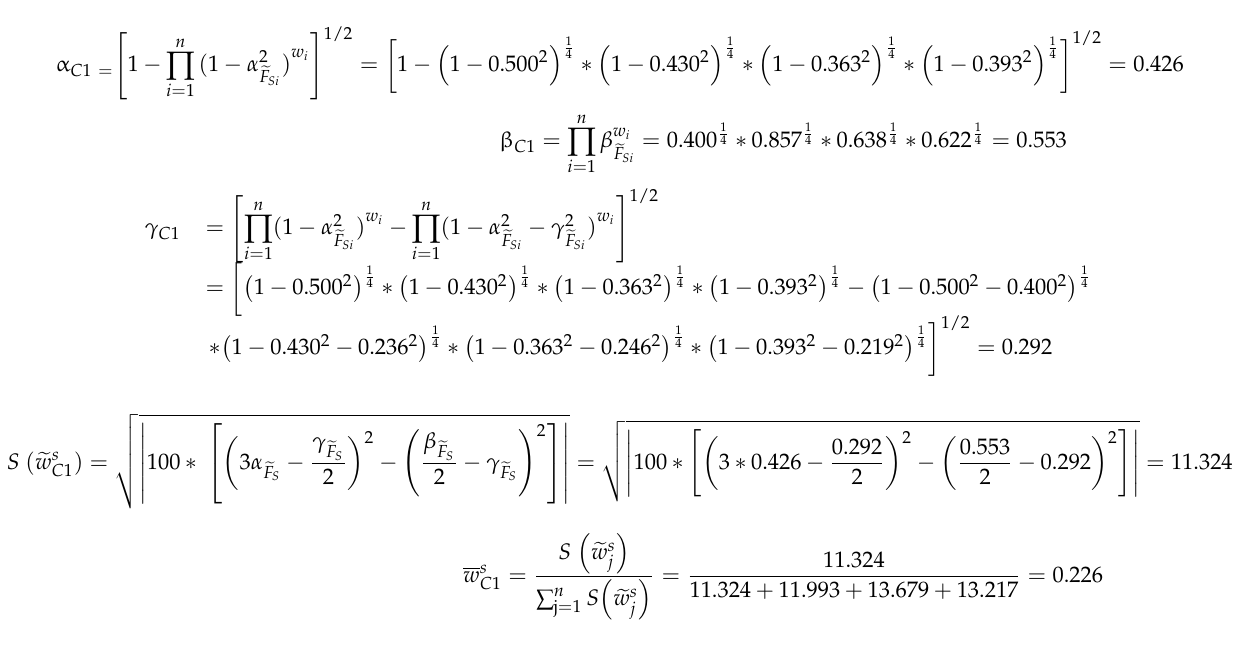
Table 9. The integrated spherical fuzzy comparison matrix. Dimension